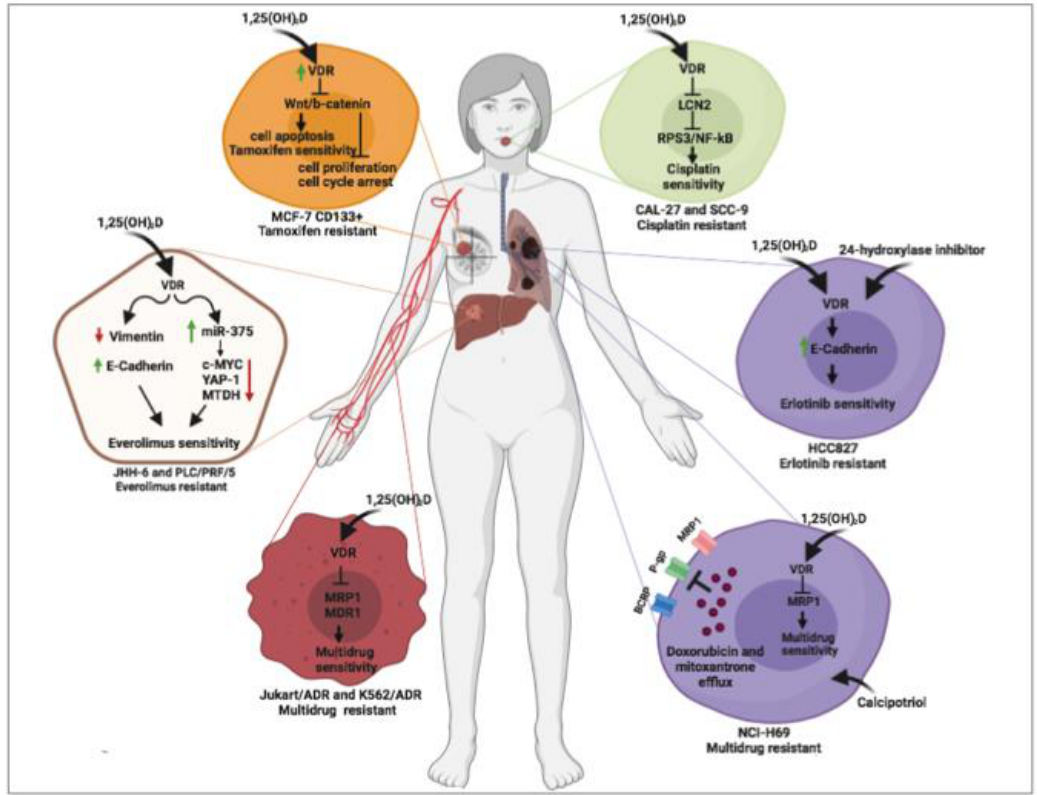
Figure 1. Vitamin D-induced molecular mechanisms involved in reversing drug-resistance in several tumors: oral, breast, liver and lung tumors and leukemia.